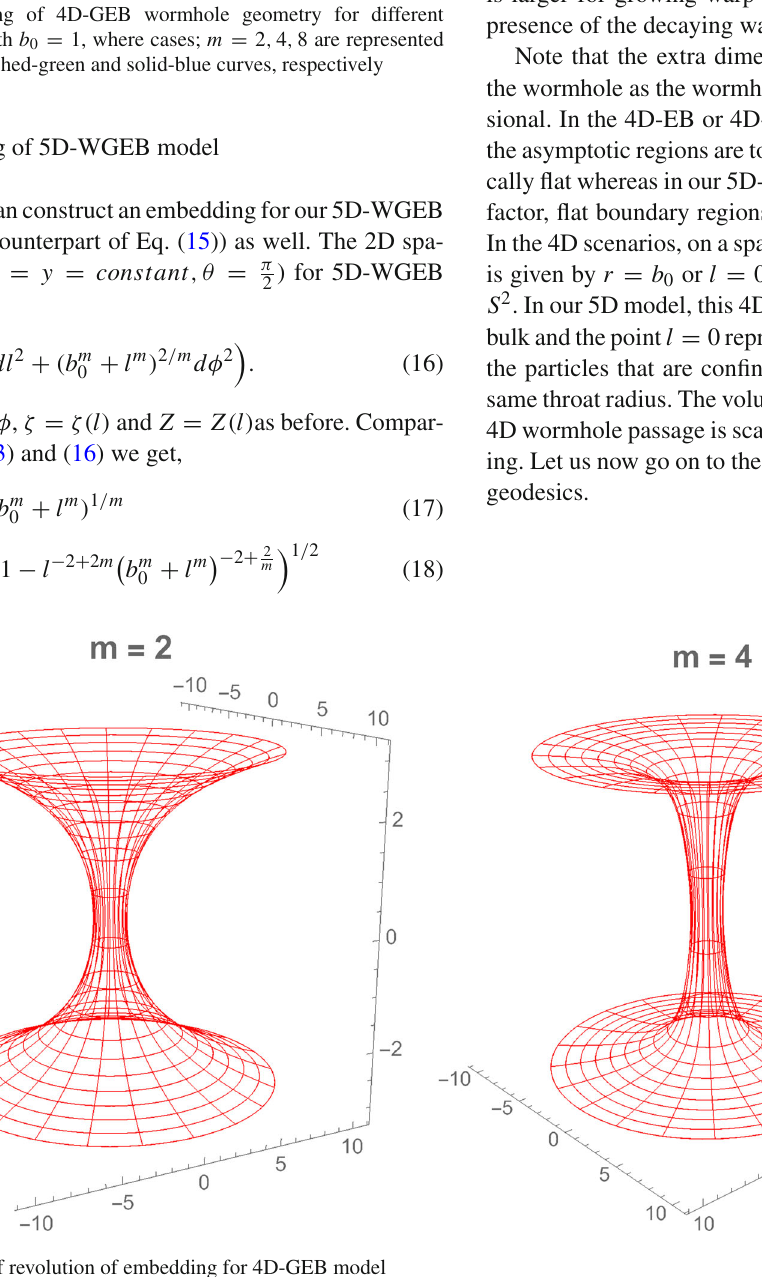
Fig. 2 Surface of revolution of embedding for 4D-GEB